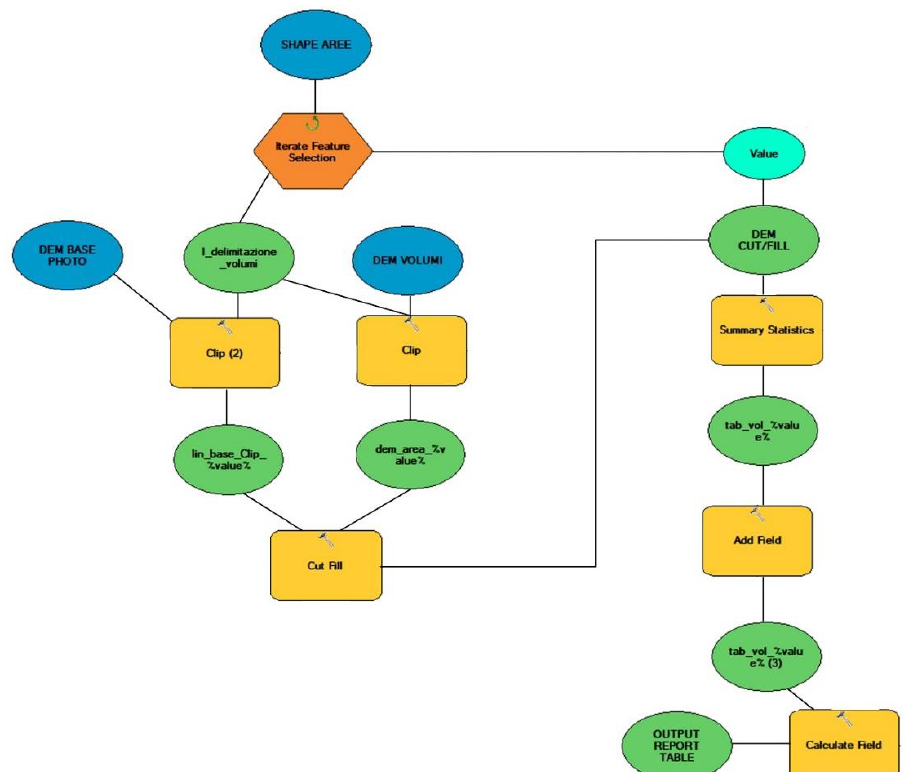
Figure 21. Process chart in the ArcGIS Model Builder tool.